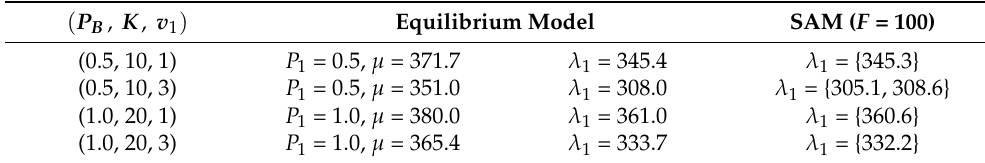
Table 3. Large capacity networks with frequent arrival rate broadcast (Case II).